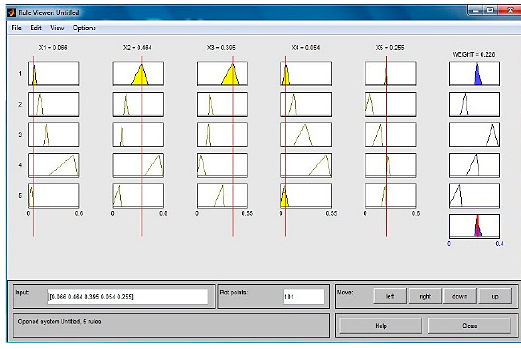
fig. 8. output function a